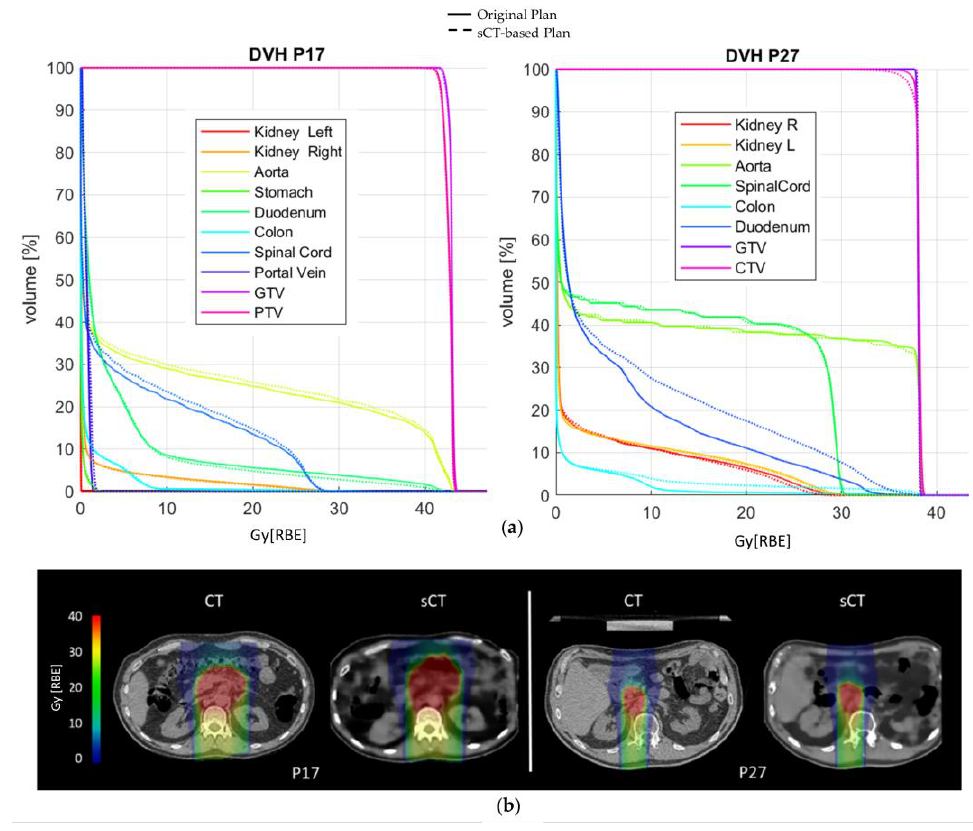
Figure 3. ( a ) DVH comparison on patients P17 and P27; ( b ) original CIRT plan (RBE) and sCT-based recalculation for patients P17 and P27.